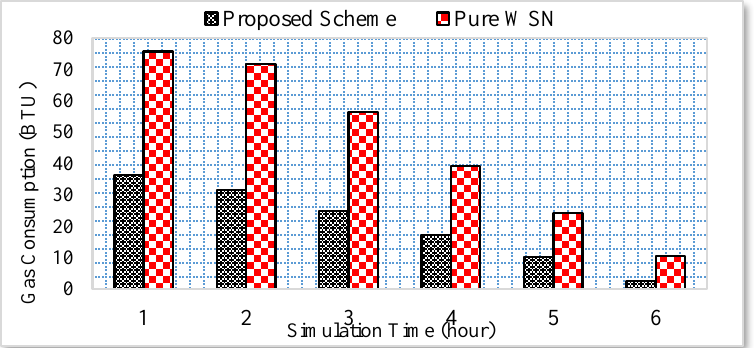
Figure 8. Gas consumption analysis.